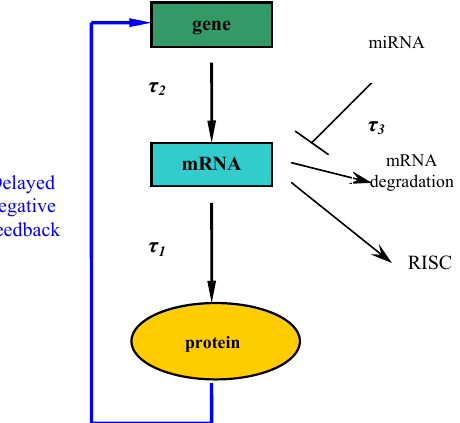
Fig. 2. Scheme of transcription ( τ 1 ) and transla- tion ( τ 2 ) time delay negative feedback control of protein